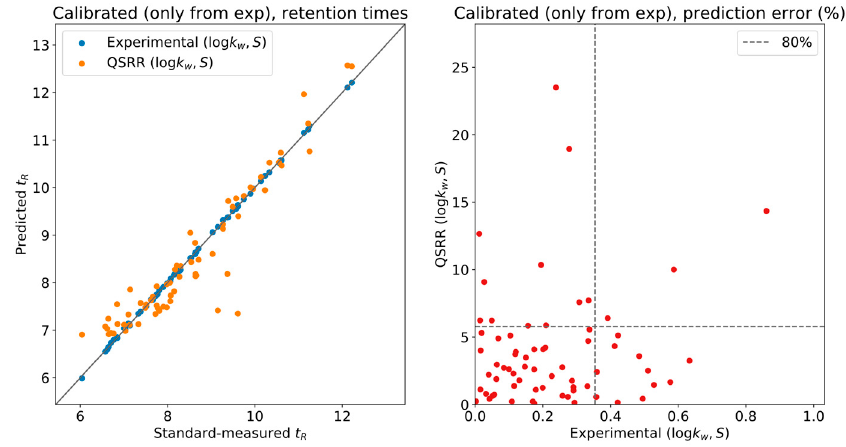
Figure 3. Experimentally calibrated retention times.